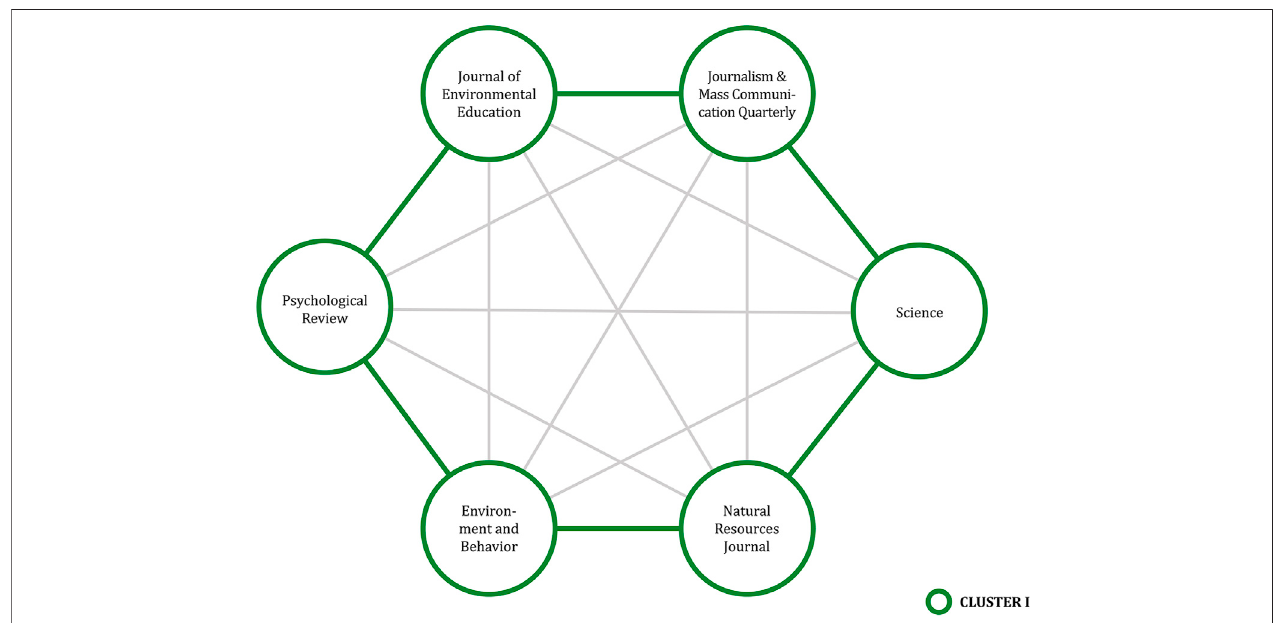
FIGURE 3 | 1970 – 1989 journal co-citation network; SWI (Small World Index) (cid:1) 1; density (cid:1) 1; transitivity (cid:1) 1; diameter (cid:1) 1; degree centralization (cid:1) 0; average path length (cid:1) 1.